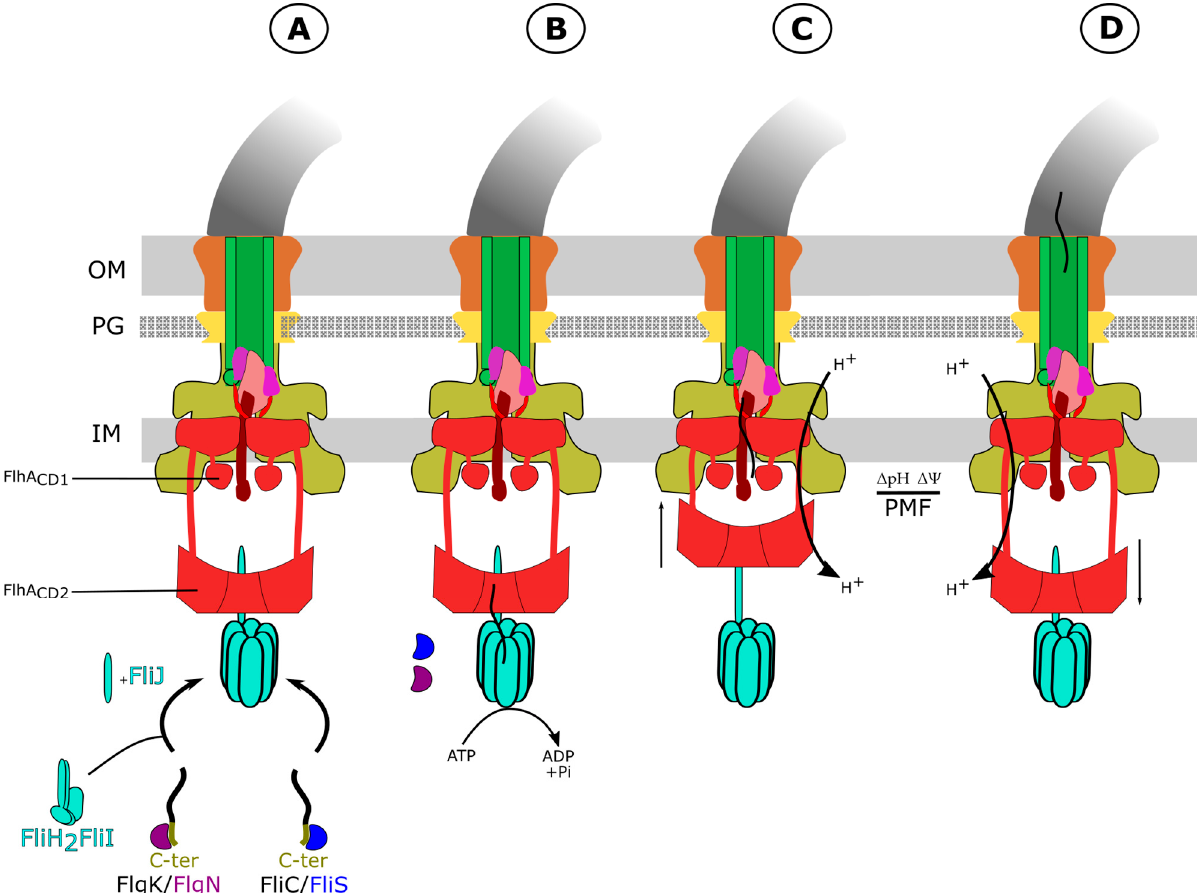
Figure 3. Putative model of the fT3SS secretion process. ( A ) Delivery of chaperones/substrates complexes to the FliH 12 FliI 6 FliJ ATPase complex, followed by ( B ) removal of the chaperone/unfolding of the substrates mediated by ATP hydrolysis of the ATPase complex FliH 12 FliI 6 FliJ and delivery to FlhA. ( C ) Proton-driven cyclical movements of the FlhA CD2 ring cause an opening of the export gate and mediate cycles of secretion substrate binding and release into the secretion channel. ( D ) Diffusion of secreted substrates inside the secretion channel to the tip of the flagellar structure.